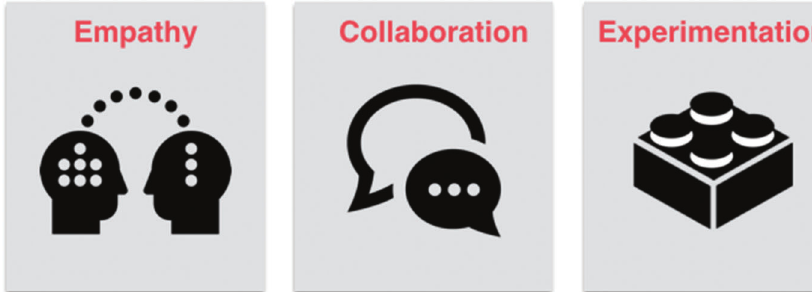
Figure 1 - Design Thinking - main